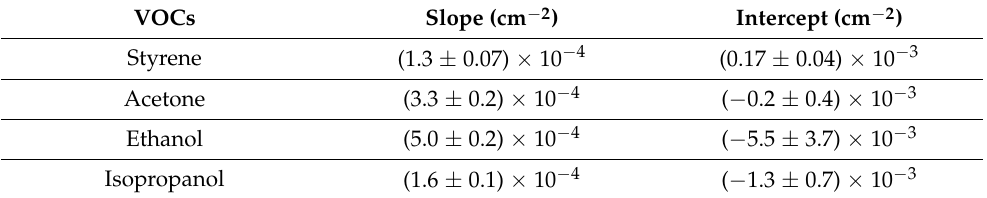
Table 1. Slope and intercept associated with the linear fit of styrene, acetone, ethanol and isopropanol.